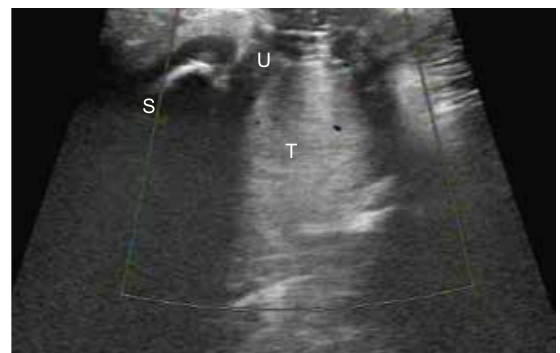
Figure 1 Transperineal sonography revealed a vaginal tumor in a one- year-old girl. The blood flow was sparse. U, urethra; S, symphysis publis; T,